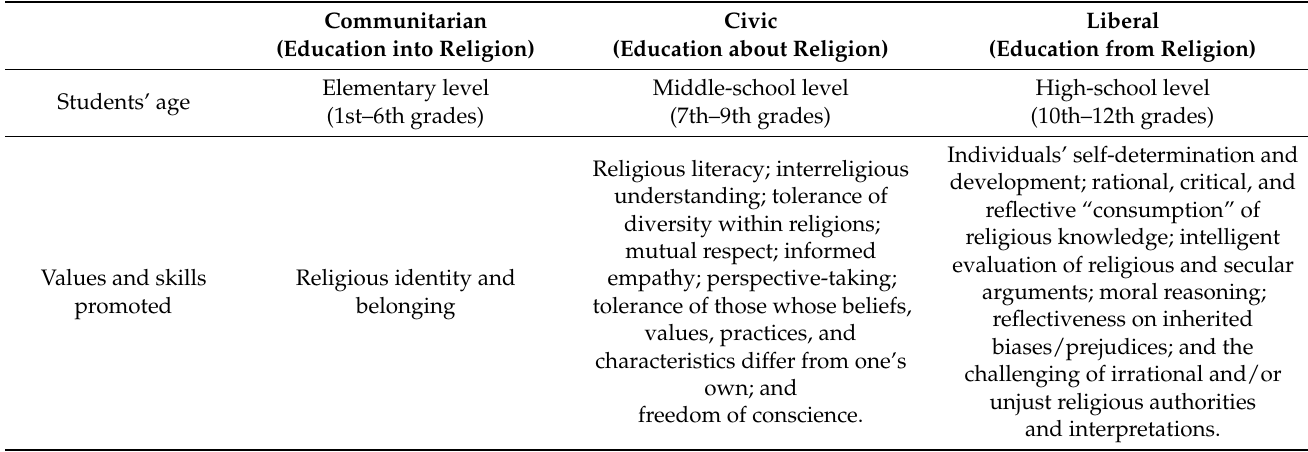
Table 1. The three aims of religious